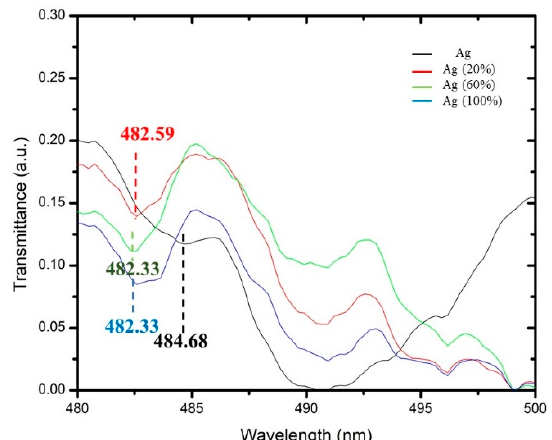
Figure 6. The surface plasmon resonance (SPR) sensor’s transmittance spectra versus the wavelength of Ag wavelength shifts at different alcohol refractive indexes, where (black line) Ag at a 484.68 nm (red line) wavelength of Ag 482.59 nm sensed at 20% of alcohol (green line); 482.33 nm of Ag sensed at 60% of alcohol; and (blue line) Ag sensed at 100% of alcohol concentration placed at the same wavelength as 60% of the alcohol at 482.33 nm.